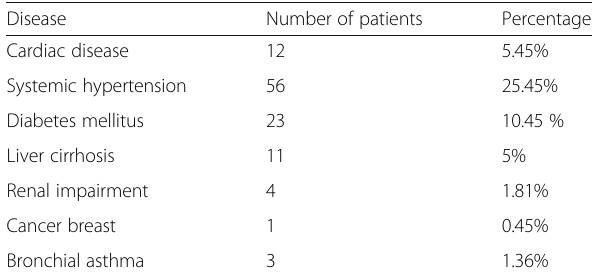
Table 1 List of patients ’ number and percent known to have systemic or chronic diseases Disease Number of patients Cardiac disease